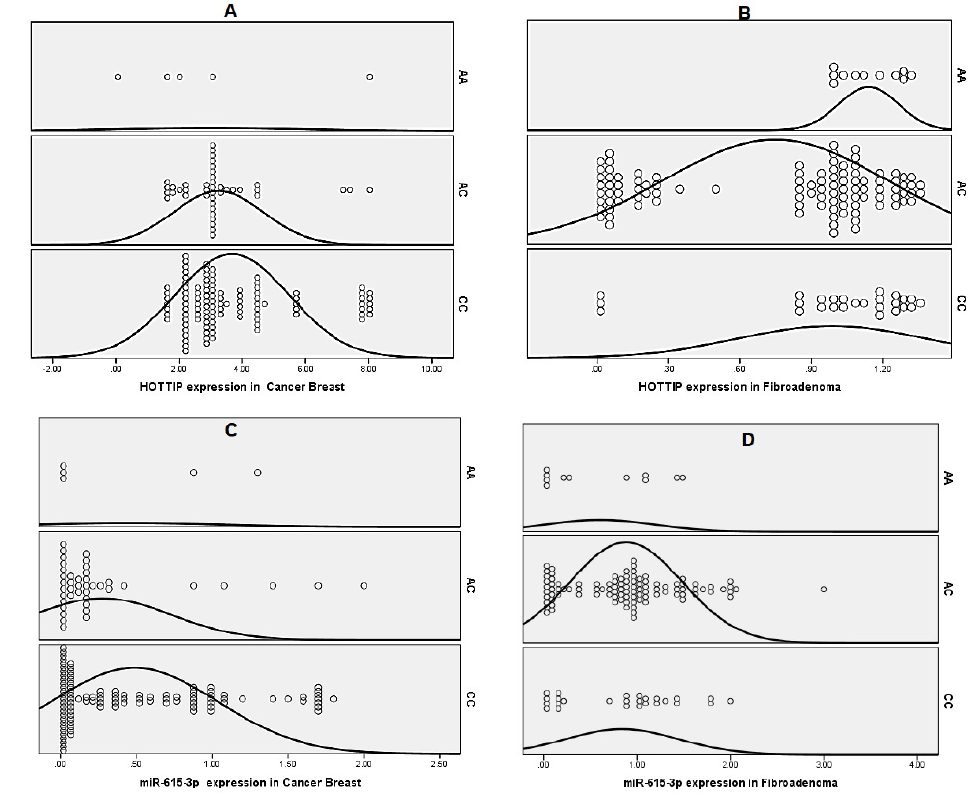
Figure 2. Dot plot representation of the effect of HOTTIP (rs1859168) polymorphism on the expression of serum HOTTIP and miR-615-3p in patients with BC and FA. ( A ) Relative expression of the fold change of the serum HOTTIP in different genotypes of rs1859168 in patients with breast cancer. ( B ) Relative expression of the fold change of the serum HOTTIP in different genotypes of rs1859168 in patients with fibroadenoma. ( C ) Relative expression of the fold change of the serum miR-615-3p in different genotypes of rs1859168 in patients with breast cancer. ( D ) Relative expression of the fold change of the serum miR-615-3p in different genotypes of rs1859168 in patients with